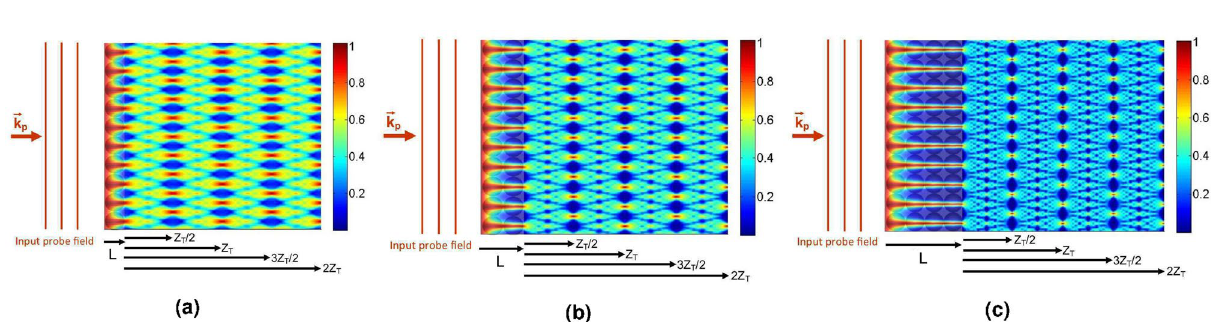
Figure 11. The propagation of the probe field amplitude inside the QDM medium, | E p ( x , z )/ E p ( 0 ) | , and outside it, | ψ p ( X , Z )/ E p ( 0 ) | , for different lengths of the QDM medium, i.e. ( a ) L = 2.5 µ m, ( b ) L = 5.25 µ m, and ( c ) L = 10.5 µ m. The tunneling parameter is fixed at T e = Ŵ , whereas other parameter values are the same as in Fig. 4.